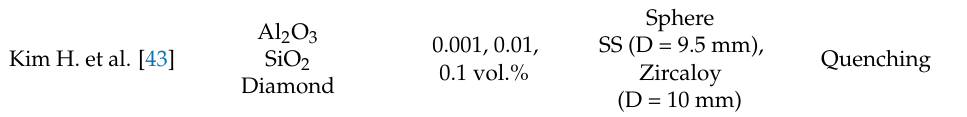
Table 3. Review of experimental studies on CHF of nanofluids in pool boiling on other surfaces.